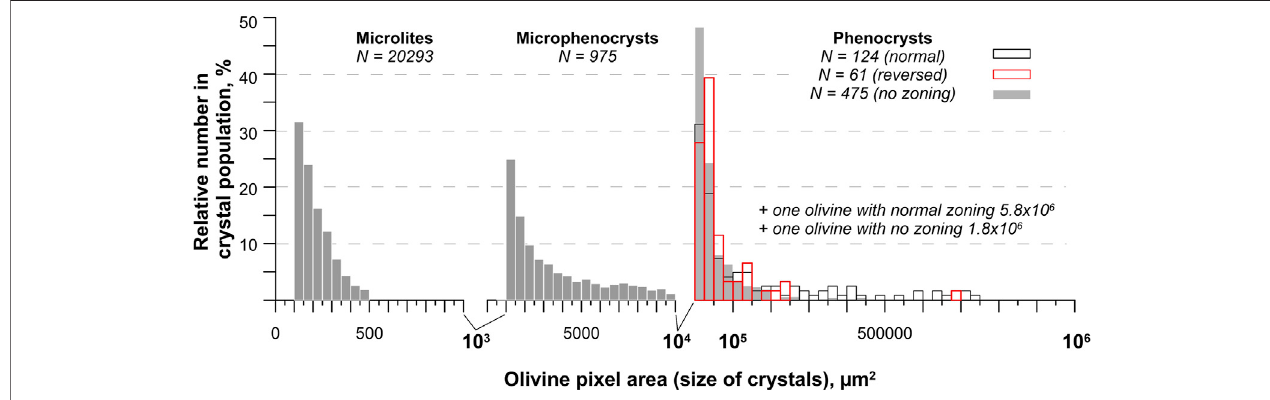
FIGURE 11 | Distribution of olivine crystal sizes (pixel area in μ m 2 ) in microlite, microphenocryst and phenocryst groups recovered from the entire thin section. See text for details.